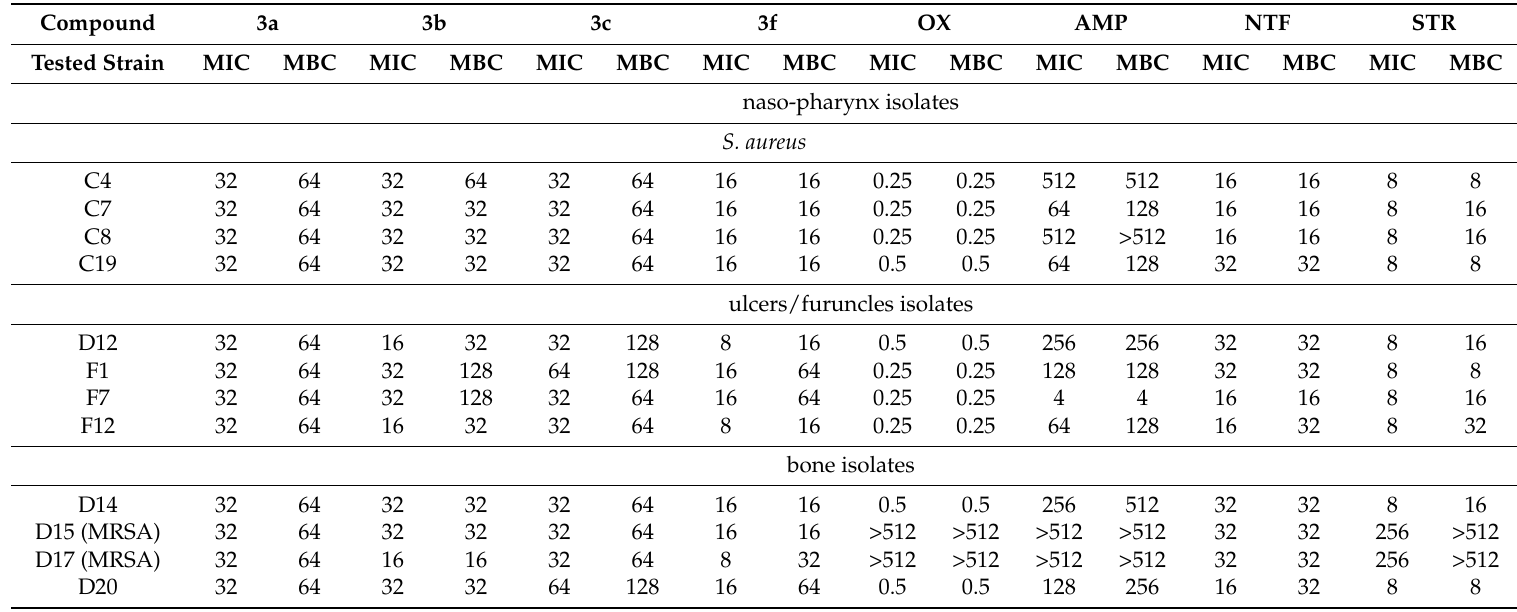
Table 4. In vitro activity of 3a , 3b , 3c , 3f against clinical isolates of S. aureus expressed as the minimal inhibitory concentration (MIC) ( µ g/mL) and minimal bactericidal